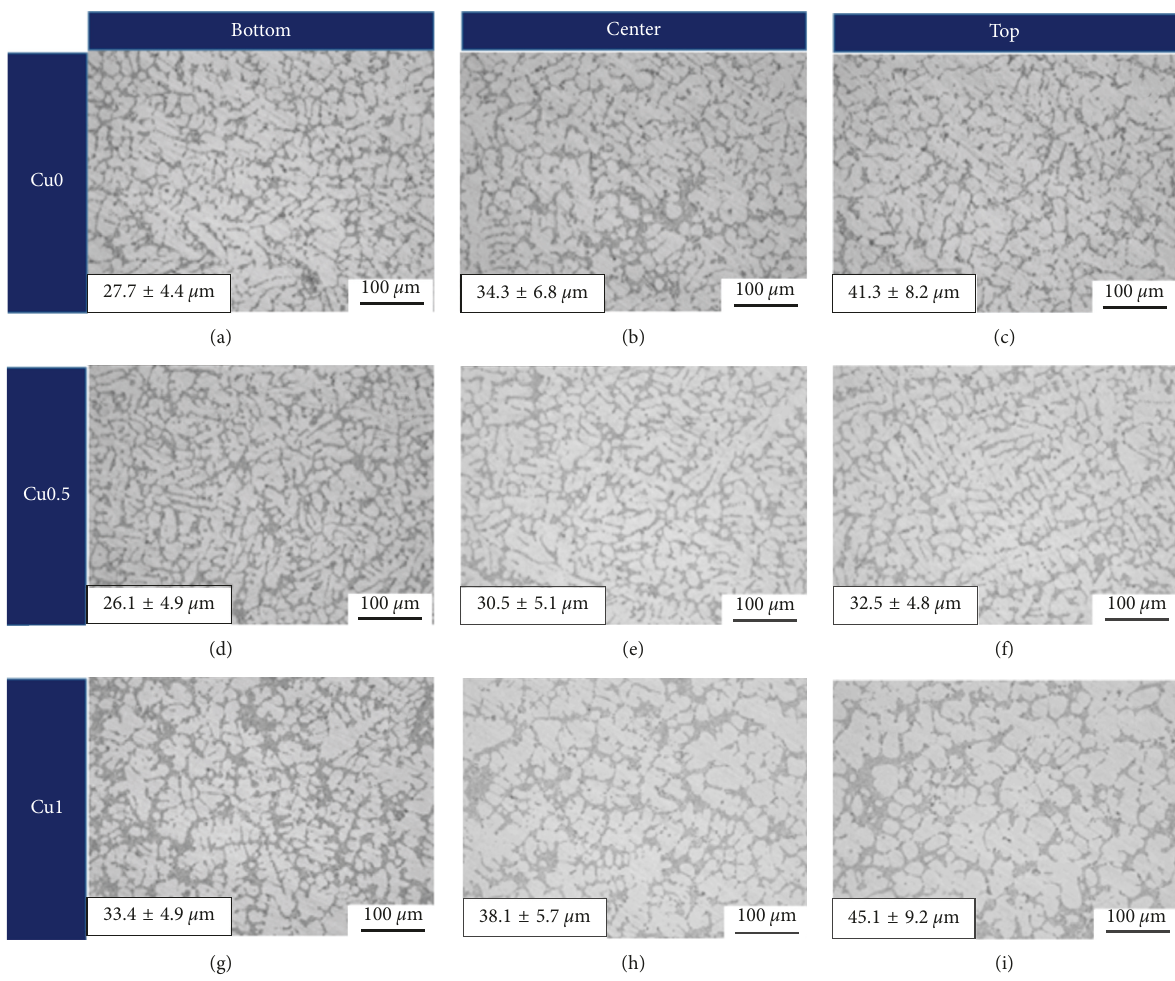
Figure 3: Optical micrographs and SDAS measurements as function of Cu content and specimen cutting position. Micrographs depict the microstructure of the Cu-free alloy (a)–(c), the 0.5% Cu alloy (d)–(f), and the 1% Cu alloy (g)–(i) with SDAS ranging from 30 up to ∼ 40 µ